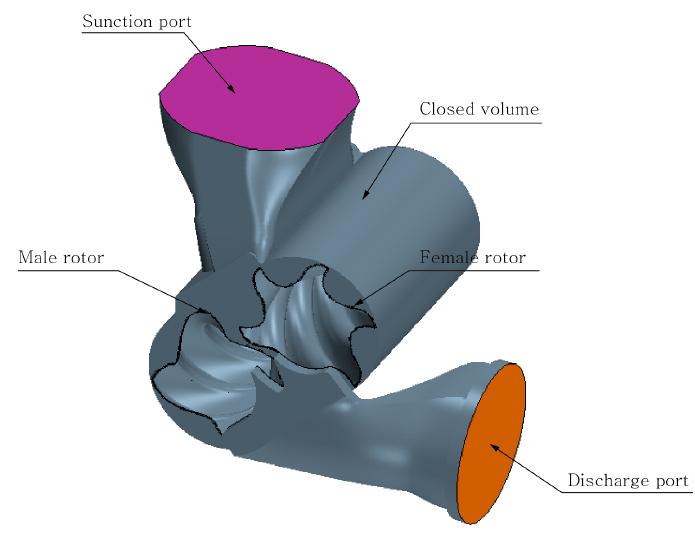
Figure 5. Control volume of the twin-screw compressor.